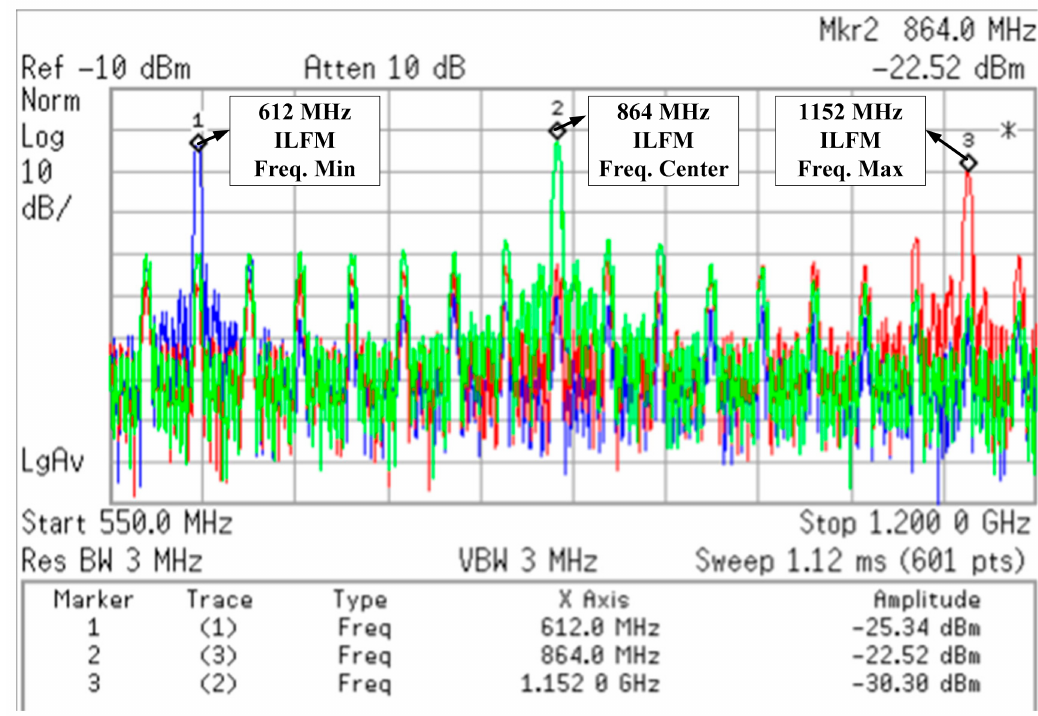
Figure 12. Injection Locked frequency range of